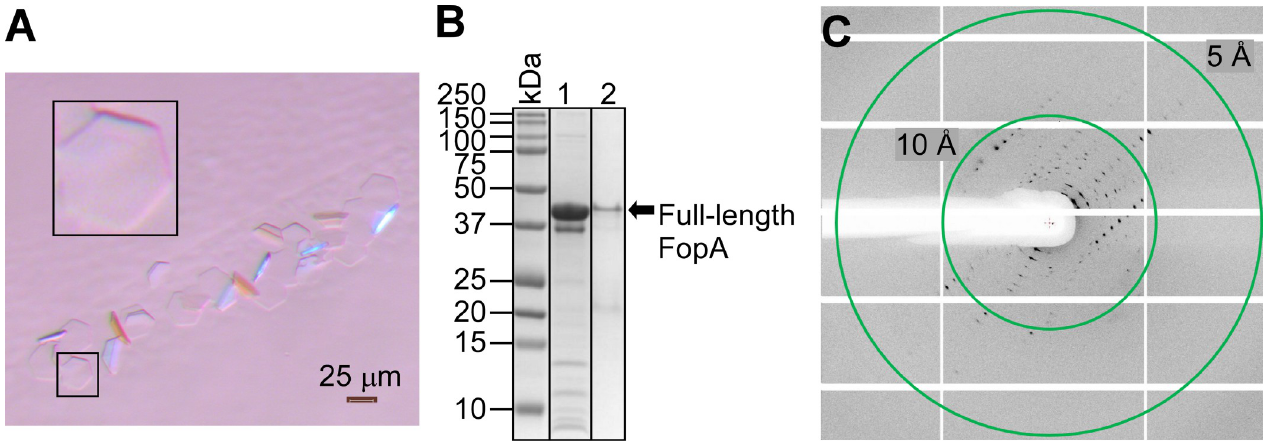
Fig 8. Crystallization of mature FopA and X-ray diffraction. (A) polarized light micrograph of FopA crystals. The larger black inset panel is an enlarged view of a planar hexagonal crystal that is shown in the small black inset panel. (B) SDS-PAGE of washed crystals. The mature FopA protein is present in the crystals as confirmed by the Coomassie-stained SDS-PAGE gel. Lane 1, mature FopA protein that was used in the crystallization; lane 2, mature FopA from isolated and washed crystals. (C) X-ray diffraction pattern from a single FopA crystal. Resolution rings are shown as green circles.